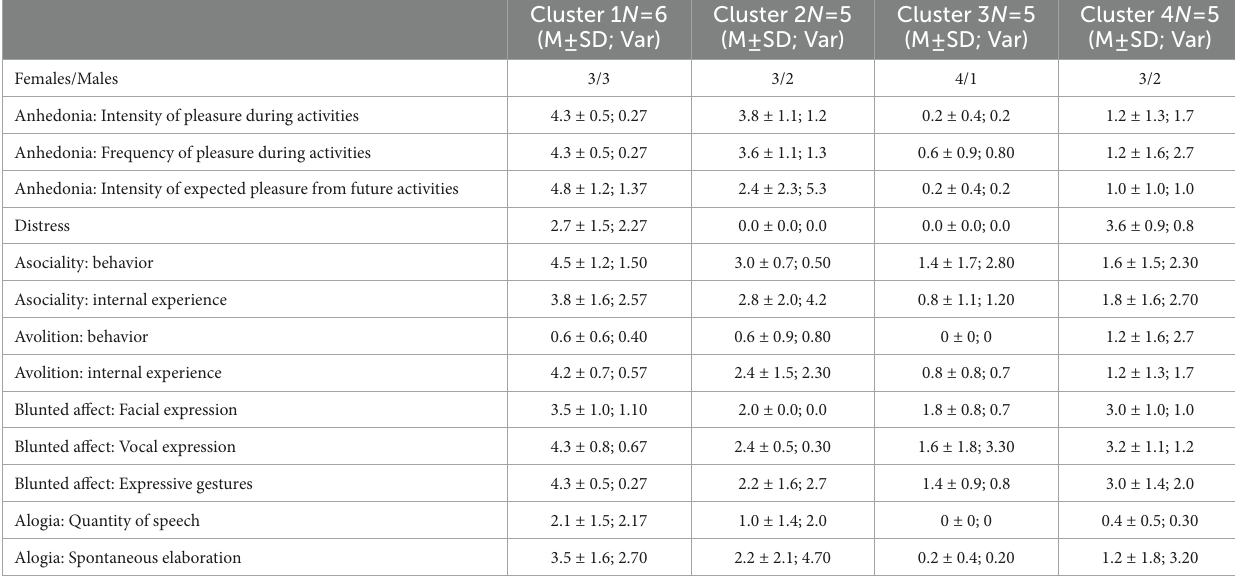
TABLE 7 Cluster analysis of BNSS